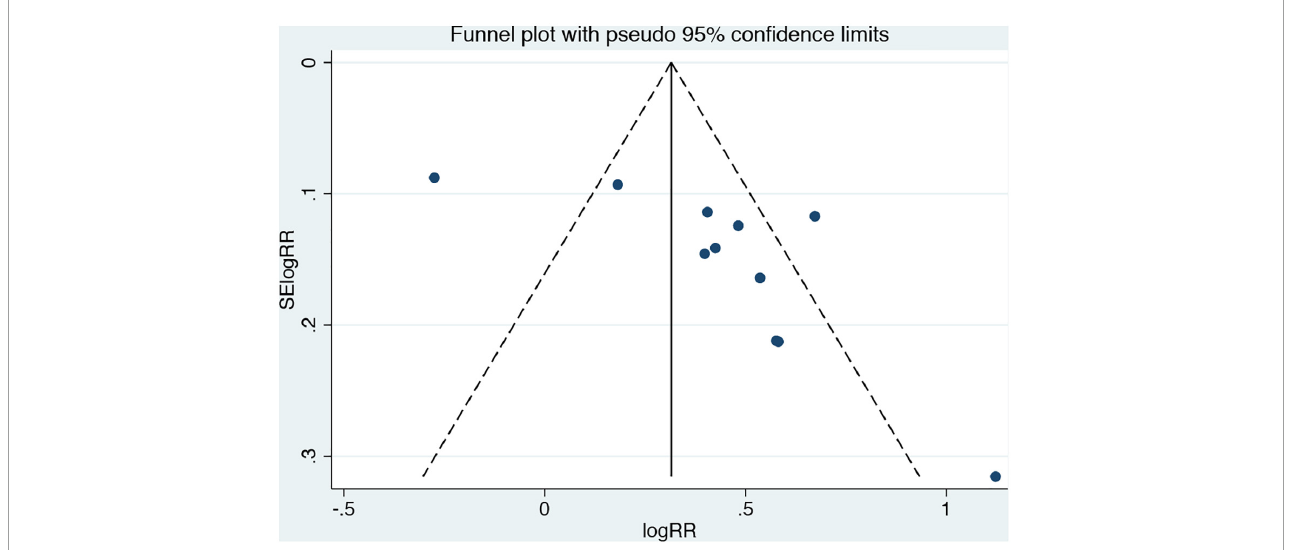
FIGURE4 Funnel plots for the analysis of remnant cholesterol concentration and composite endpoint events. Results compare participants in the highest versus lowest remnant cholesterol